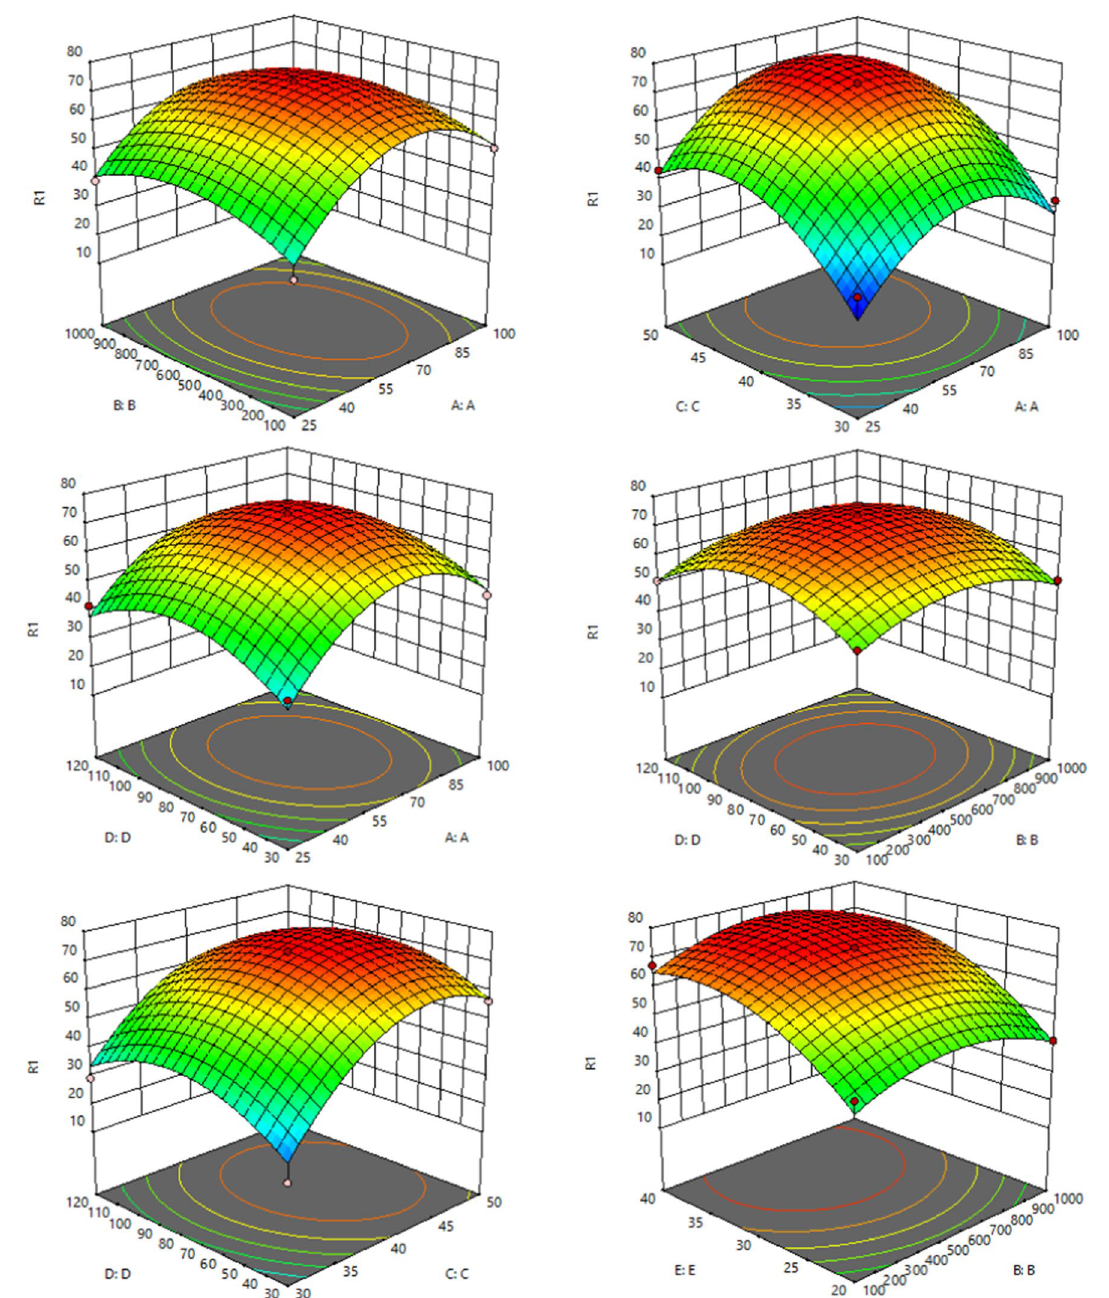
Fig. 3 Response surface plot depicting the effect of various parameters for melanoidin removal via Cu-impregnated activated